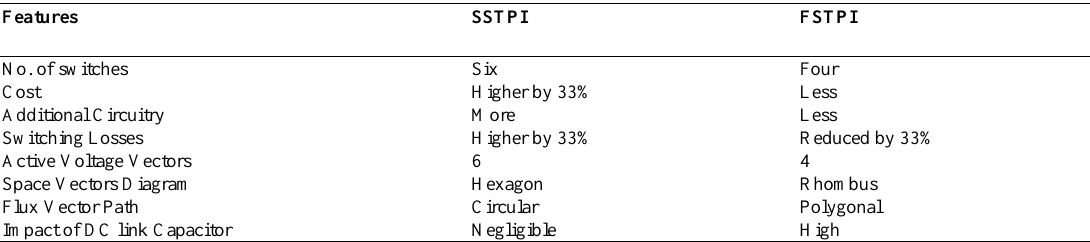
Table 1. Comparison between SSTPI &